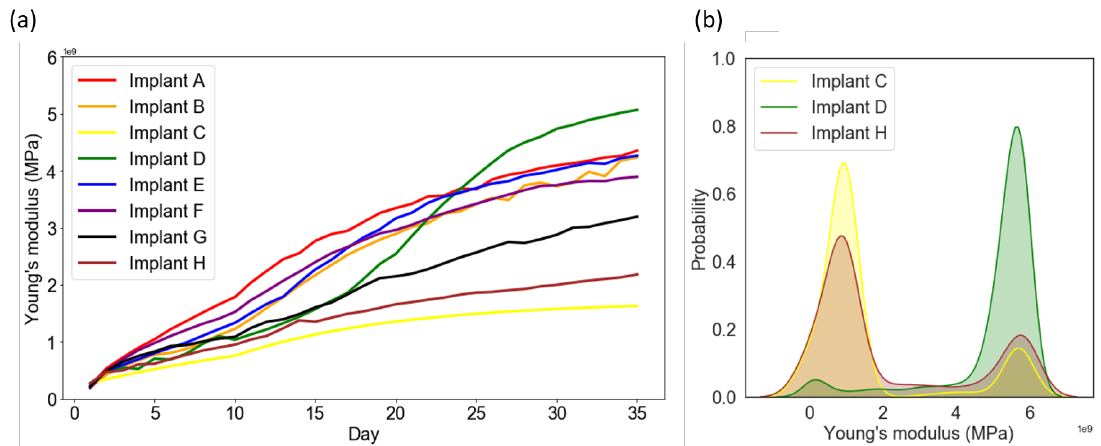
Figure 5. ( a ) The overall averaged Young’s modulus evolution in the callus region for implant A–H. ( b ) The Young’s modulus distribution of each element in the callus region for implants C, D,